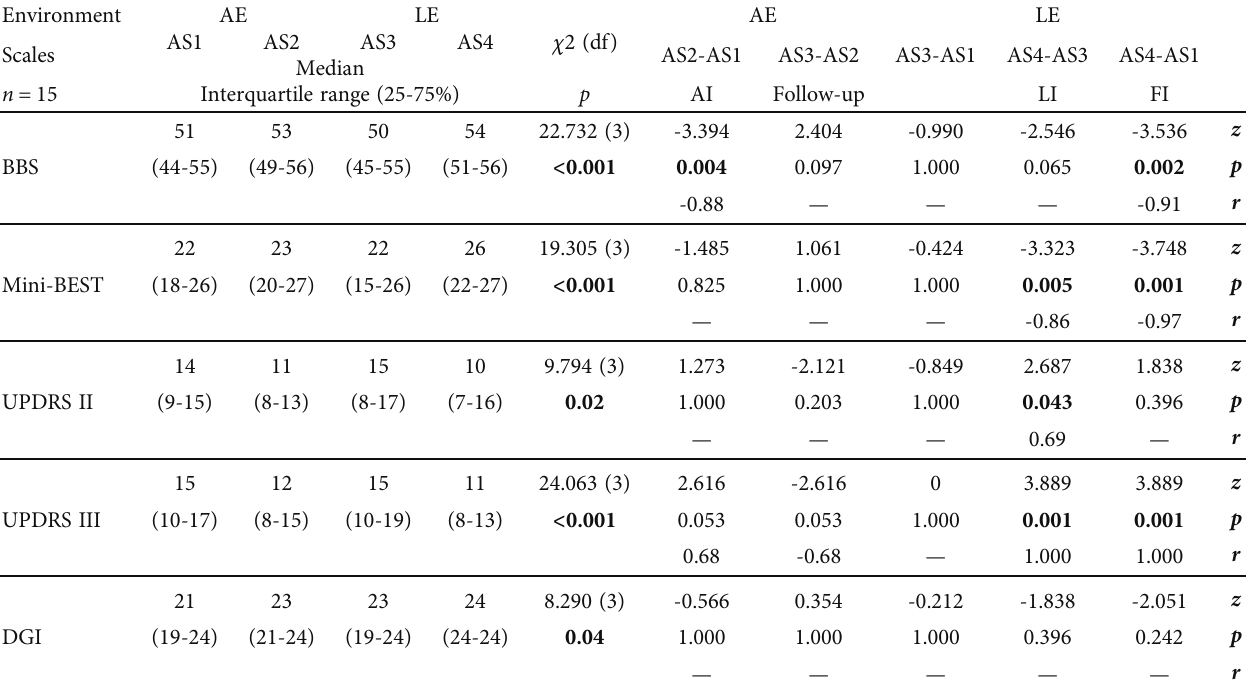
Table 3: Comparative analysis of balance, motor aspects, and activities of daily living of people with Parkinson ’ s disease after the sequential multimodal intervention program in aquatic and land